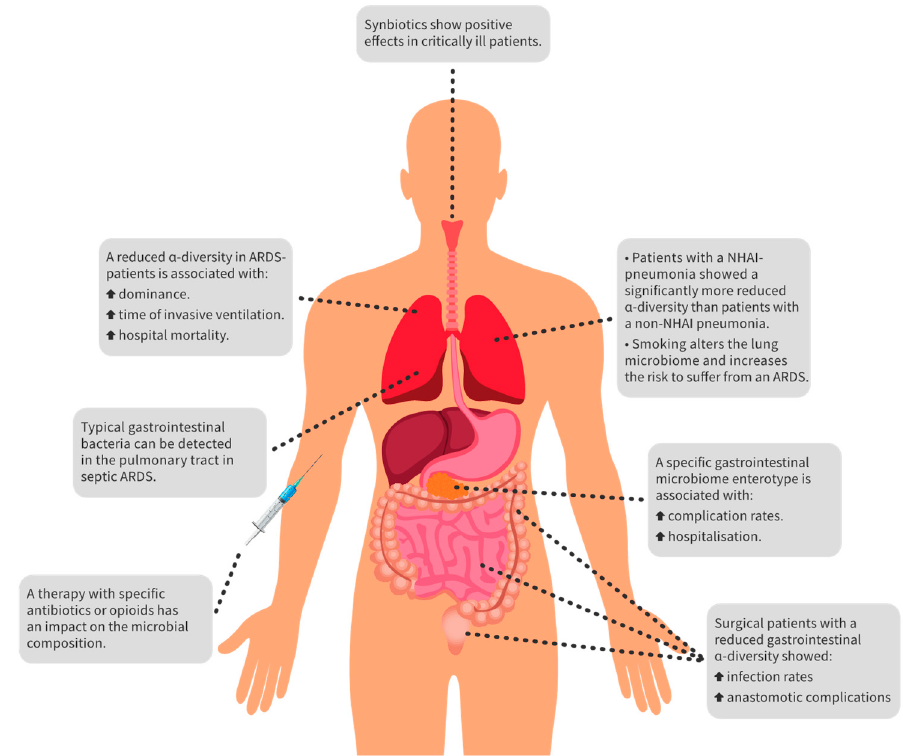
Figure 1 . Overview of the key findings. There are many ways to influence the microbiome in critically ill patients with sepsis and ARDS. For example, antibiotics and opioids harm the balance of the microbiome. On the other hand, it appears that probiotics have a positive influence on dysbiosis. Furthermore, typical gastrointestinal bacteria can be detected in the lungs of ARDS patients and are indicative of lung dysbiosis. Overall, reduced alpha diversity in the gut and lungs is associated with more complications and increased hospital mortality. Abbreviations: ARDS, acute respiratory distress syndrome; NHAI-pneumonia, nursing-home and hospital-associated infection-pneumonia.